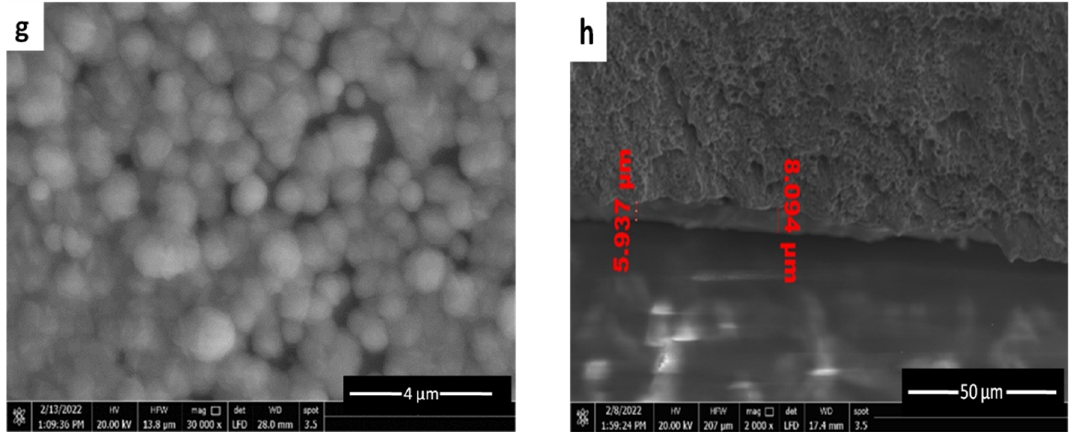
Figure 7. SEM of ncCuAg co-deposited from bath I at different operating conditions: ( a ) 1.14 mA cm − 2 , 10 min.; ( b ) 1.72 mA cm − 2 , 10 min; ( c ) 2.29 mA cm − 2 , 10 min; ( d ) 3.43 mA cm − 2 , 10 min.; ( e ) 1.72 mA cm − 2 , 15 min; ( f ) 1.72 mA cm − 2 , 20 min.; ( g ) pure Cu, 1.72 mA cm − 2 , 10 min.; ( h ) cross section (1.72 mA cm − 2 , 10 min).